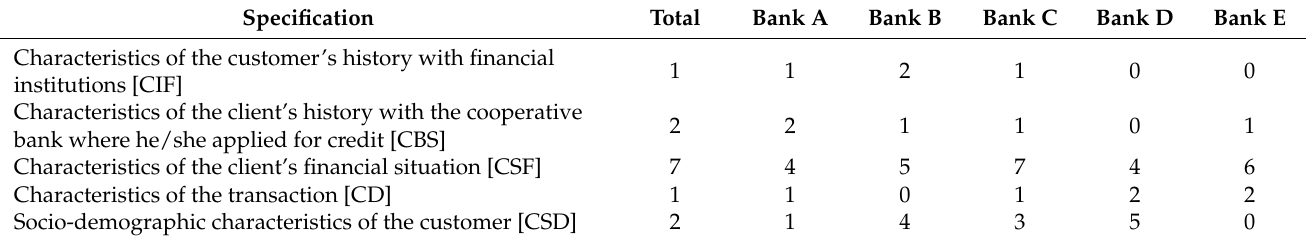
Table 3. Number of significant features in terms of IV index values by feature